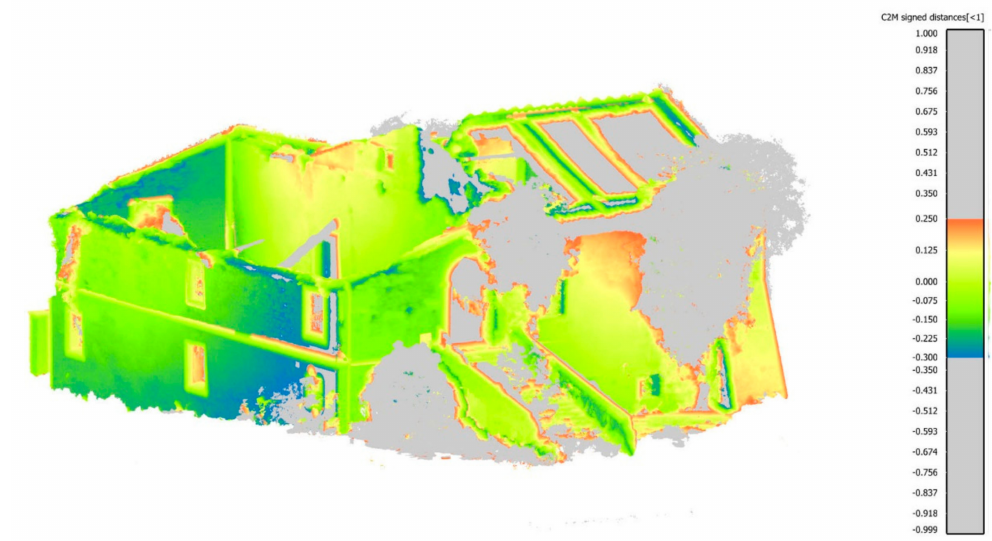
Figure 11. Calculation of the deviation between the ideal continuous BIM model and the numerical model obtained from the survey; values are expressed in